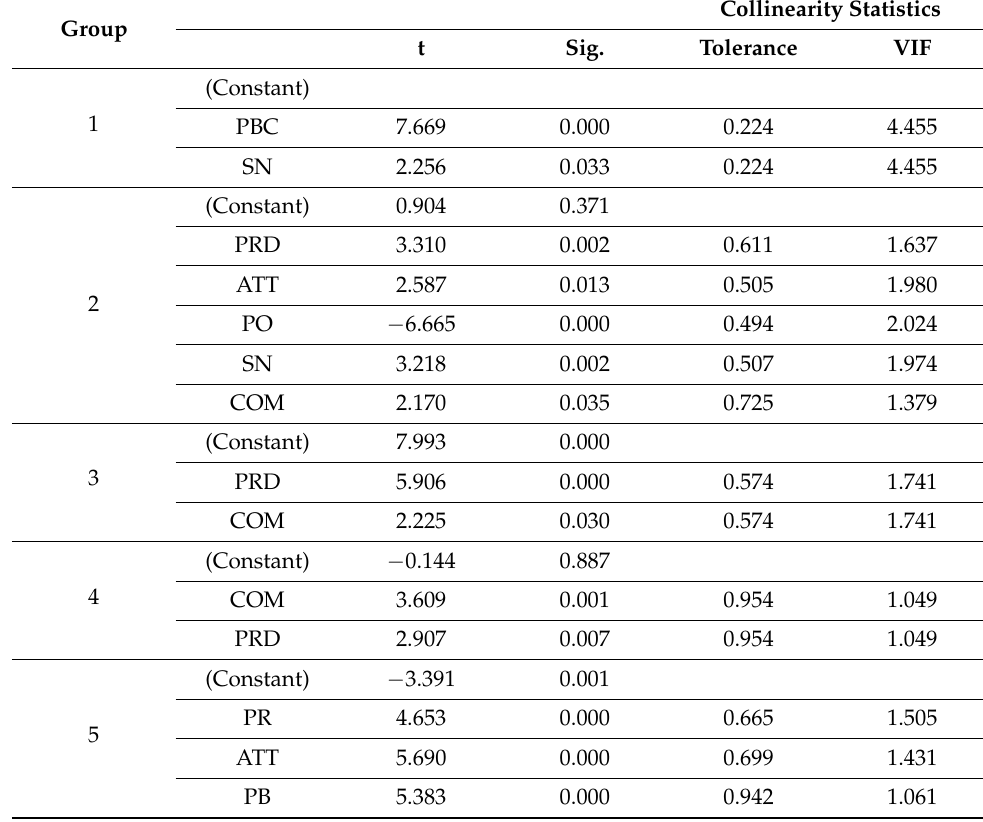
Table 8. Stepwise multiple linear regression.